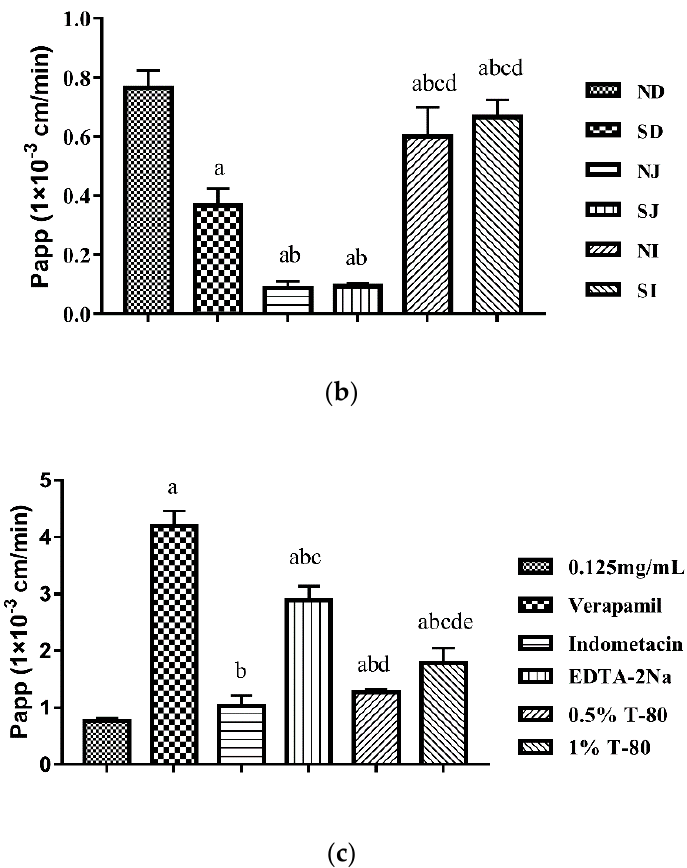
Figure 3. The influences of concentration ( a ), intestinal sections ( b ), and inhibitors ( c ) on the Papp of TIL-SLNs or tilmicosin solution. The absorption site of tilmicosin was shifted from ileum to duodenum via TIL-SLNs. The absorption efficiency of TIL-SLNs was hindered by P-gp. Note: ( a ), the Papp of various concentration of TIL-SLNs; ( b ), the Papp of TIL-SLNs in various intestine sections; ND: TIL-SLNs duodenum; SD: solution duodenum; NJ: TIL-SLNs jejunum; SJ: solution jejunum; NI: TIL-SLNs ileum; SI: solution ileum. a Statistically significant from TIL-SLNs duodenum; b Statistically significant from solution duodenum; c Statistically significant from TIL-SLNs jejunum; d Statistically significant from solution jejunum; ( c ), T-80: polysorbate-80, a Statistically significant from TIL-SLNs (0.125 mg/mL); b Statistically significant from verapamil; c Statistically significant from indomethacin; d Statistically significant from EDTA-2Na; e Statistically significant from 0.5% T-80. The statistical difference was analyzed by one-way analysis of variance at p < 0.05.